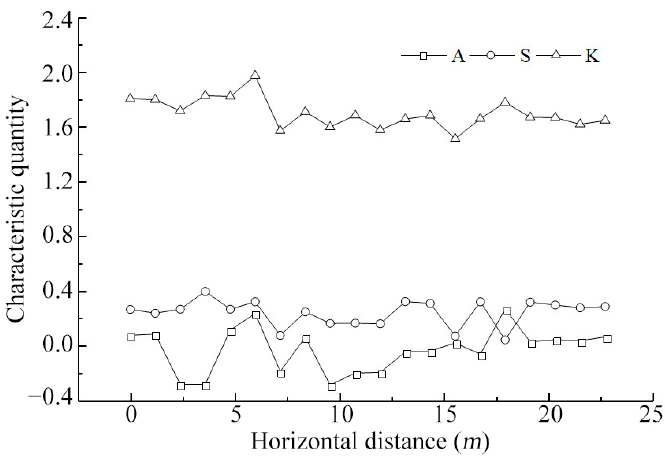
Figure 9. Nonlinear feature quantity distributed along spatial points.